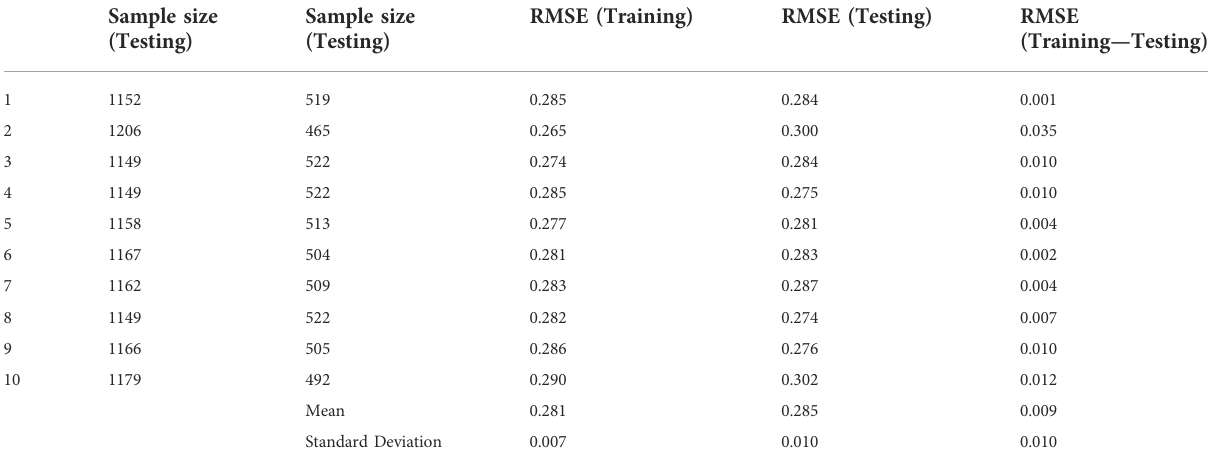
TABLE 8 RMSE values of Arti fi cial Neural Networks ( n =